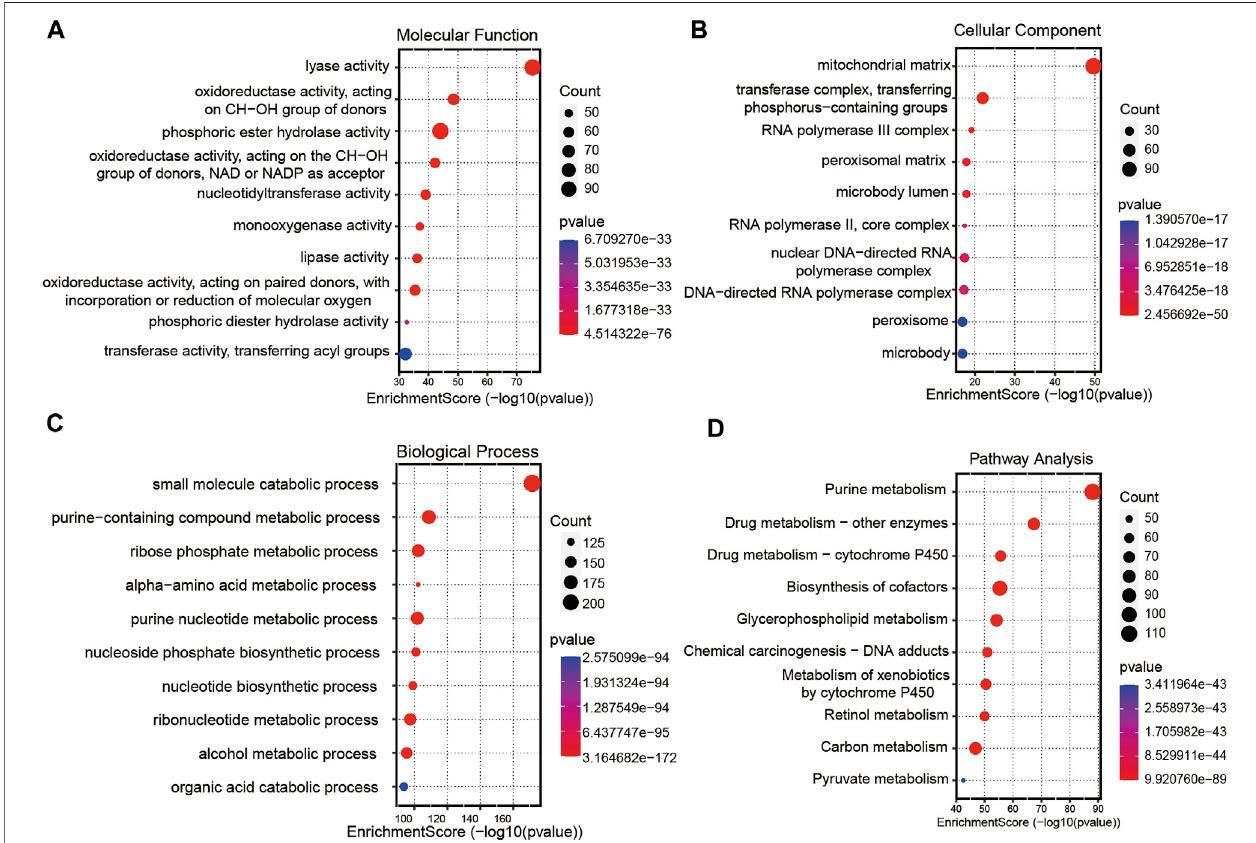
FIGURE7| Genefunctionalenrichmentanalysisofautophagy-relatedlncNRAs. (A) Thesigni fi canttermsofMF(molecularfunction)enrichment. (B) Thesigni fi cant terms of CC (cellular component) enrichment. (C) The signi fi cant terms of BP (biological process) enrichment. (D) The top 10 signi fi cant terms of KEGG analysis.